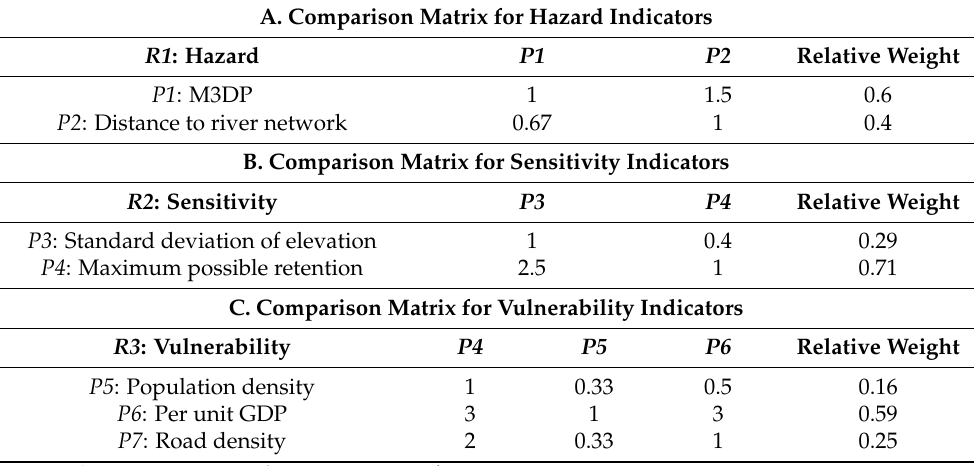
Table 4. Comparison matrix for flood risk